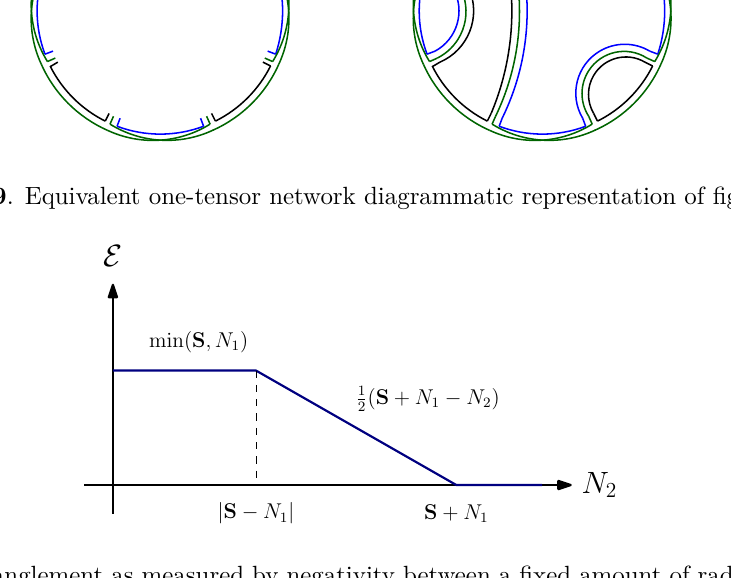
Figure 30 . Entanglement as measured by negativity between a fixed amount of radiation that we have access to, and the black hole, as a function of an increasing amount of escaping